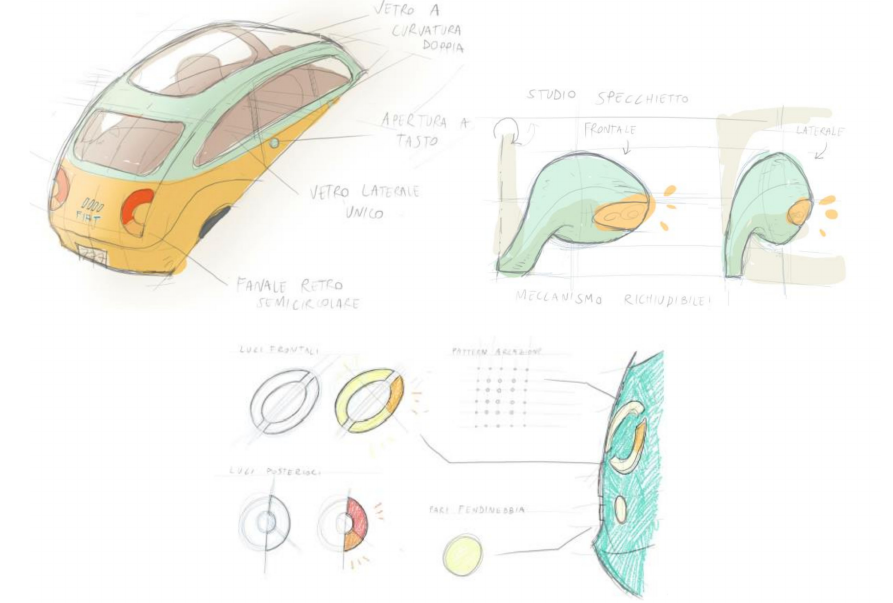
Figure 23. Sketches FIAT 600 Omega.